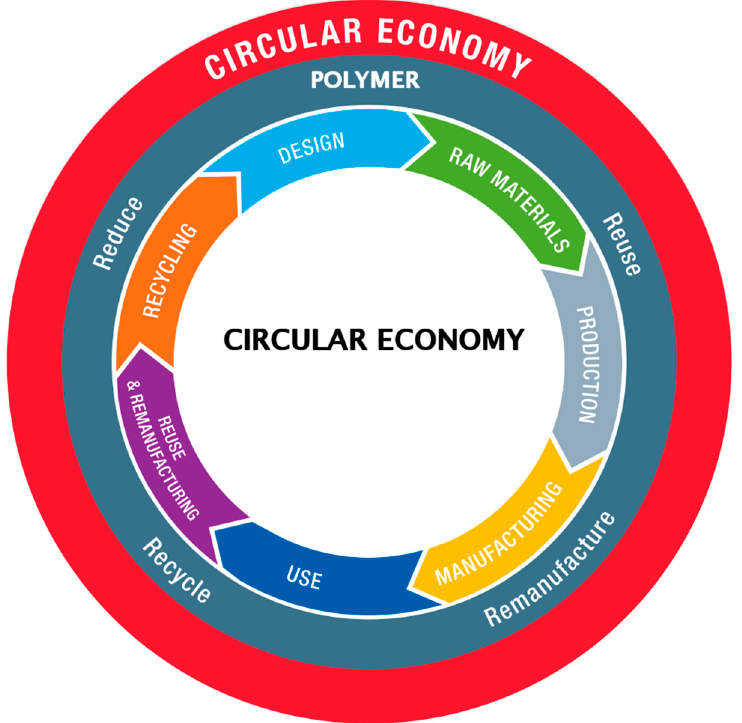
Figure 1. Circular Economy Cycle for Sustainable Development [15].